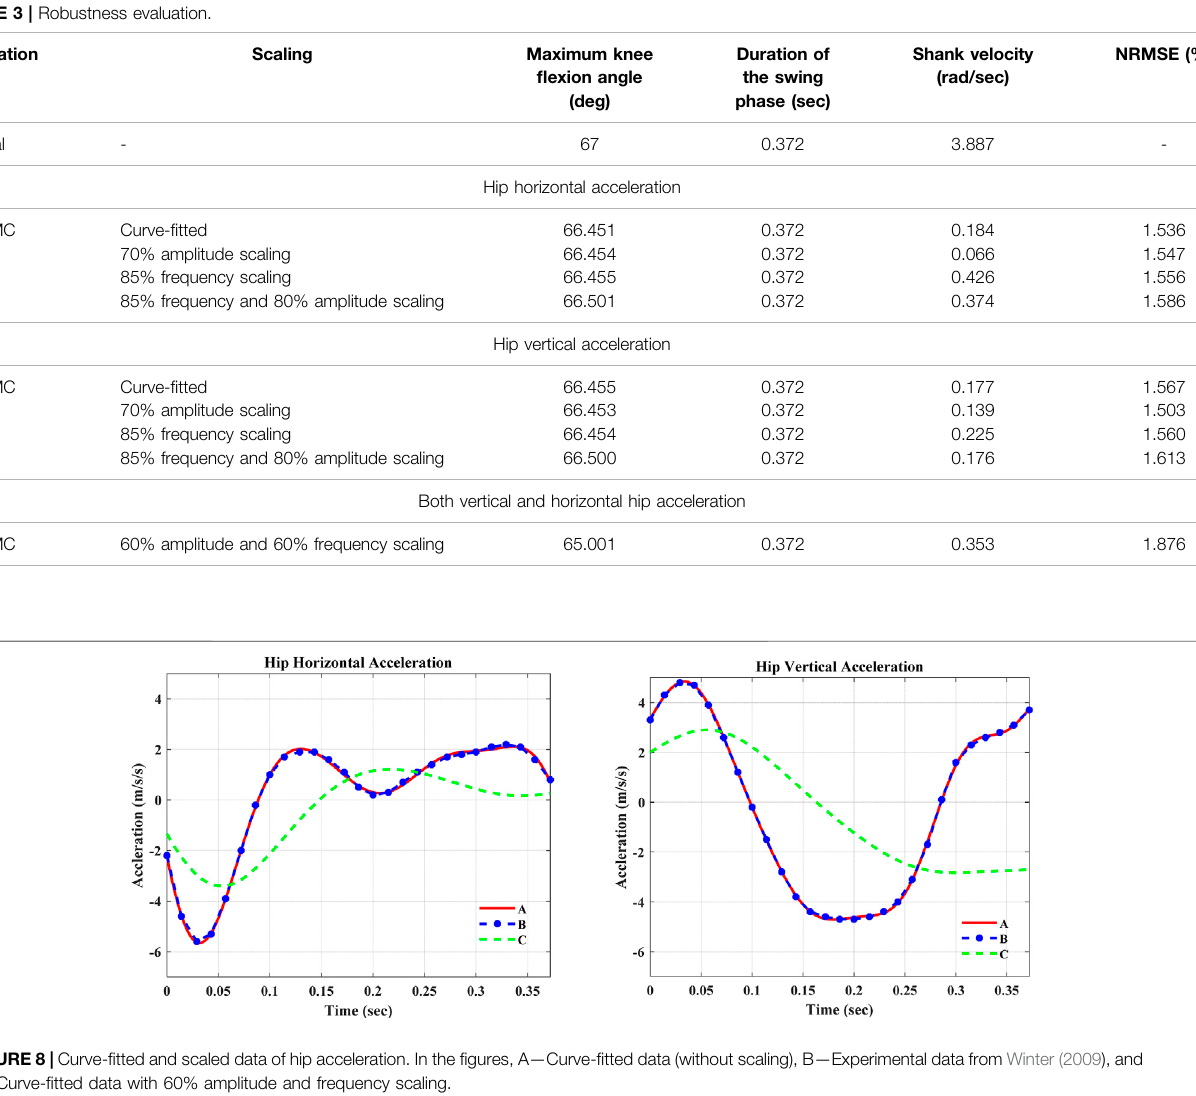
Frontiers in Robotics and AI |